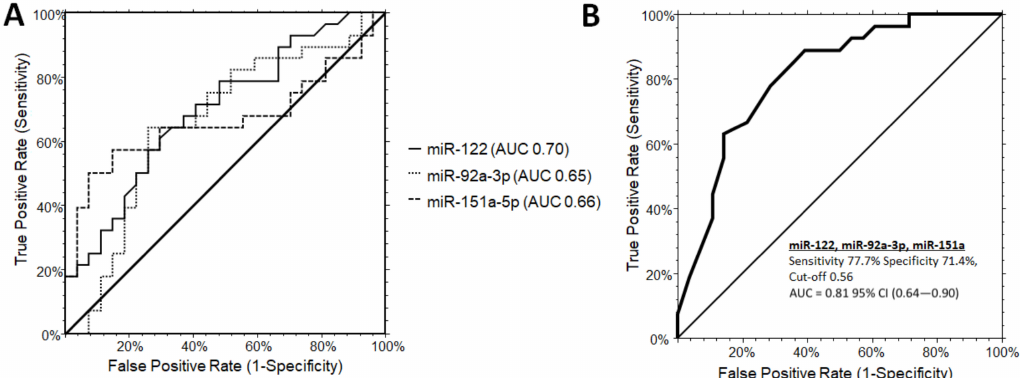
Figure 1. Receiver operating characteristic (ROC) curve analysis for single microRNAs ( A ) and combinations (B: miR-122-5p, miR-151a, miR-92a-3p) to discriminate PWS from OB subjects. ( B ) The AUC for the combination of the three miRNA was determined as 0.81 (0.64-0.90, 95% CI) with a sensitivity of 77.7% and a specificity of 71.4%, at a cut-o ff 0.56 (logit model formula: –1.34 + 2.97 × miR-122-5p - 0.57 × miR-92a_3p + 1.62 × miR-151a-5p). AUC, area under the ROC curve; CI, confidence